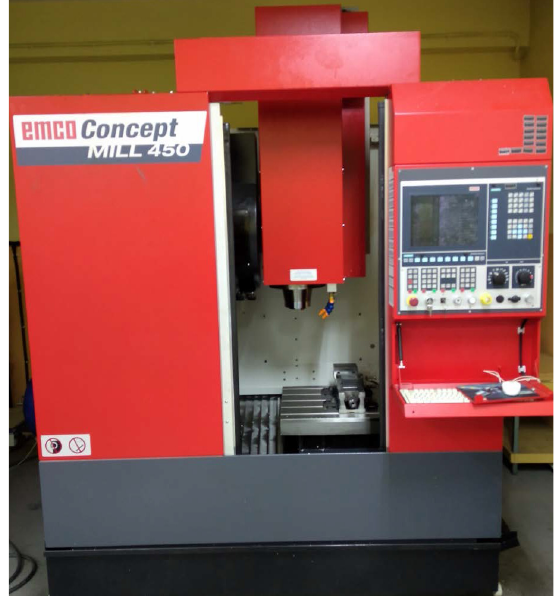
Figure 1. Experimental